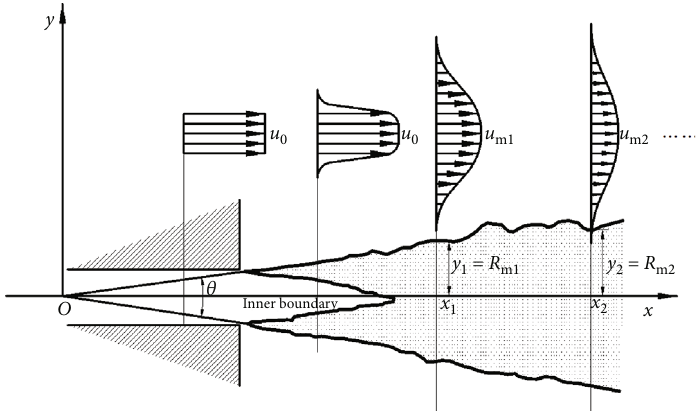
Figure 1: The structure diagram of a nonsubmerged water